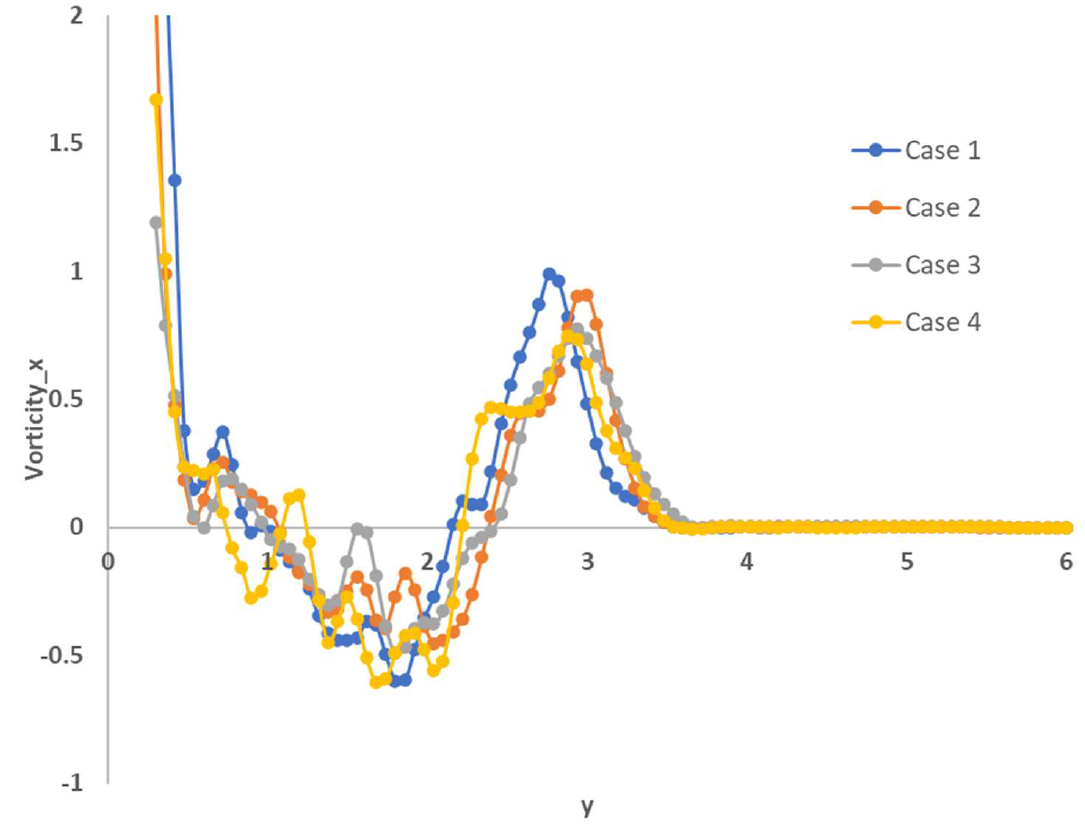
Figure 10. Distribution of the spanwise component of vorticity along the wall-normal direction.